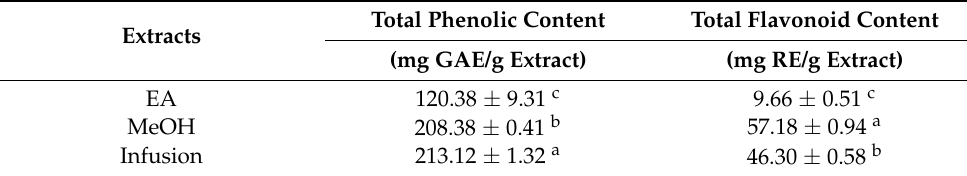
Table 1. Total bioactive components of the tested